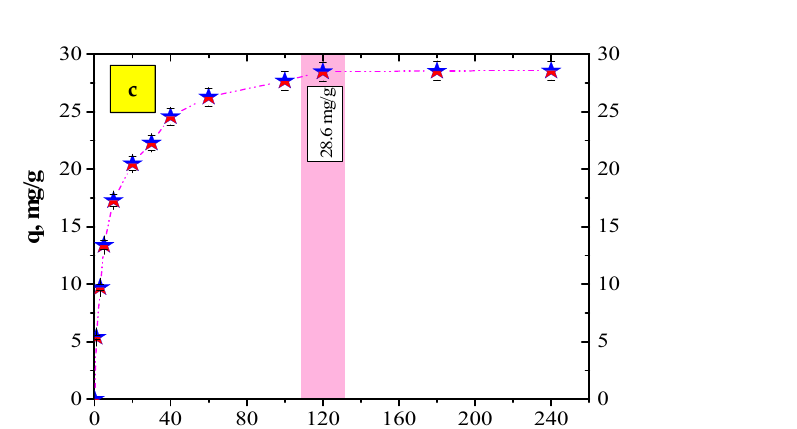
25 ◦ C); ( b ) Influence of initial concentration (pH, 5.0; contact time, 24 h; adsorbent dose, 1 g/100 mL; temperature, 25 ◦ C);